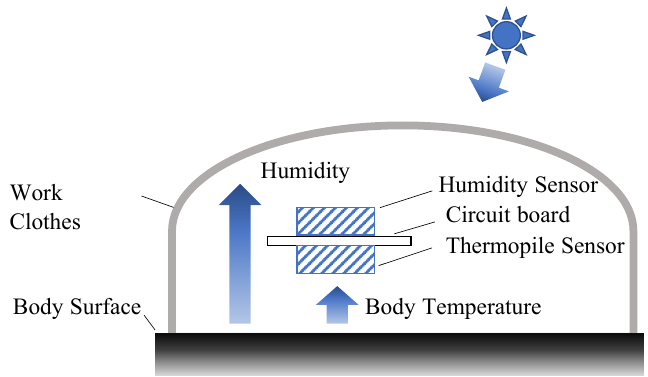
Figure 2. Principle of personalized heat strain temperature (pHST) measurement.